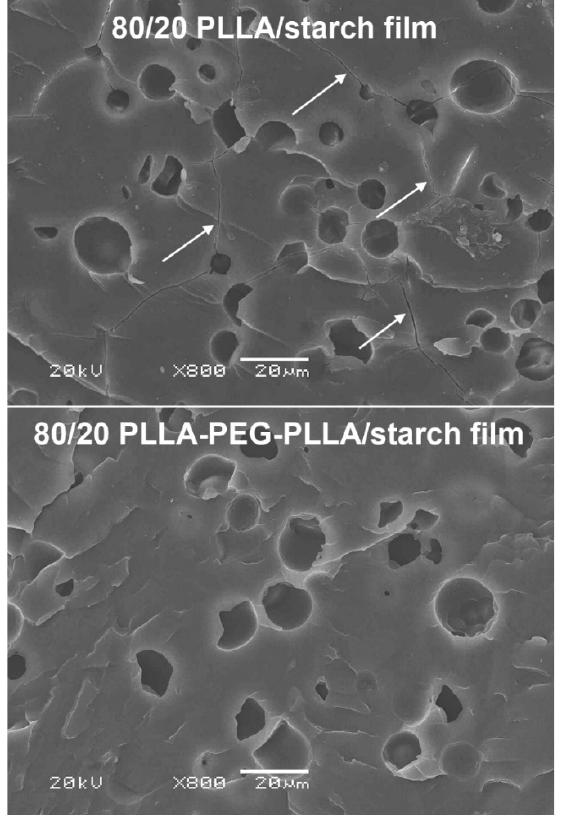
Figure 7. SEM images of cryogenically fractured surfaces for ( above ) 80/20 PLLA/starch and ( below ) 80/20 PLLA-PEG-PLLA/starch films after immersion in 6 N HCl solution for 3 h (some crack surfaces are indicated by white arrows; all bar scales = 20 µm).